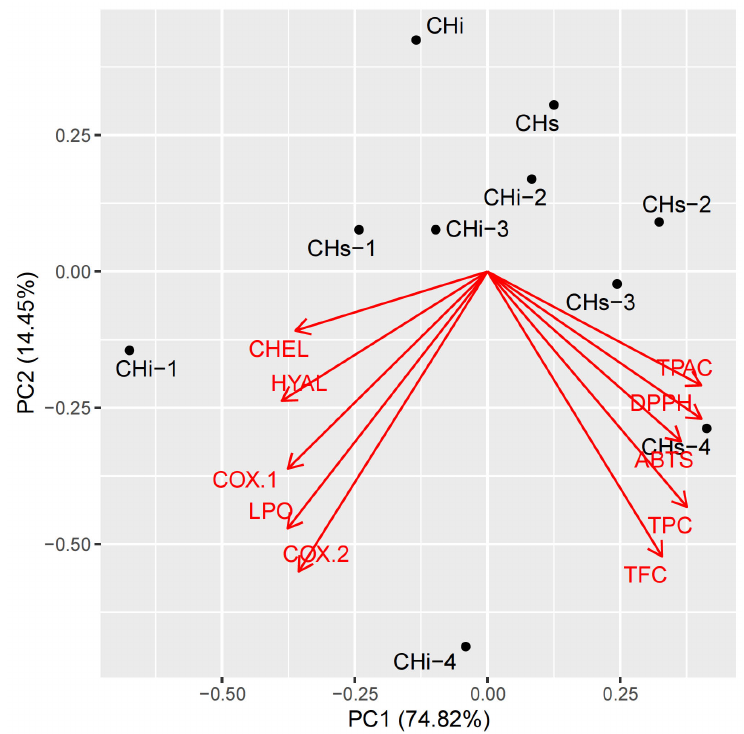
Figure 10. Principal component analysis loadings of the investigated dataset: PC1 vs. PC2 plot. TPC—Total phenolic content; TPCA—Total phenolic acids content; TFC—Total flavonoid content; CHEL—Metal chelating activity; LPO—Lipoxygenase inhibition; HYAL—Hyaluronidase inhibi ‐ tion. The analysis was done on a column ‐ wise scaled matrix, as each parameter is ex ‐ pressed with different units. Additionally, two of the parameters, DPPH and ABTS, were expressed as negative values in this matrix. This was done to convert the strong correla ‐ tion between them and TPC, TPAC, and TFC from negative to positive. This places the loading vectors in the same direction and allows us to see everything visually in more detail. It can be clearly seen that the parameters form two distinct groups, expressed as two separate groups of loading arrows and two main branches of the dendrogram. The first group contains antioxidant parameters TPC, TPAC, and TFC, together with DPPH and ABTS. The other parameters form the second group. The increase or decrease of all investigated parameters in opposite directions is re ‐ sponsible for 75% of total variance and is modeled as PC1. PC2 represents an intercorre ‐ lated increase or decrease of all investigated parameters and is responsible for 14% of the variability. Further PCs do not contain any interpretable information (results not shown). 4. Conclusions The management of acne vulgaris should be “multidirectional”. Therapeutics should reduce sebum production, as well as follicular hyperkeratinization of the epidermal cells. For this reason, they should primarily exhibit antioxidant, anti ‐ inflammatory, and antimi ‐ crobial activities, without cytotoxic effects.